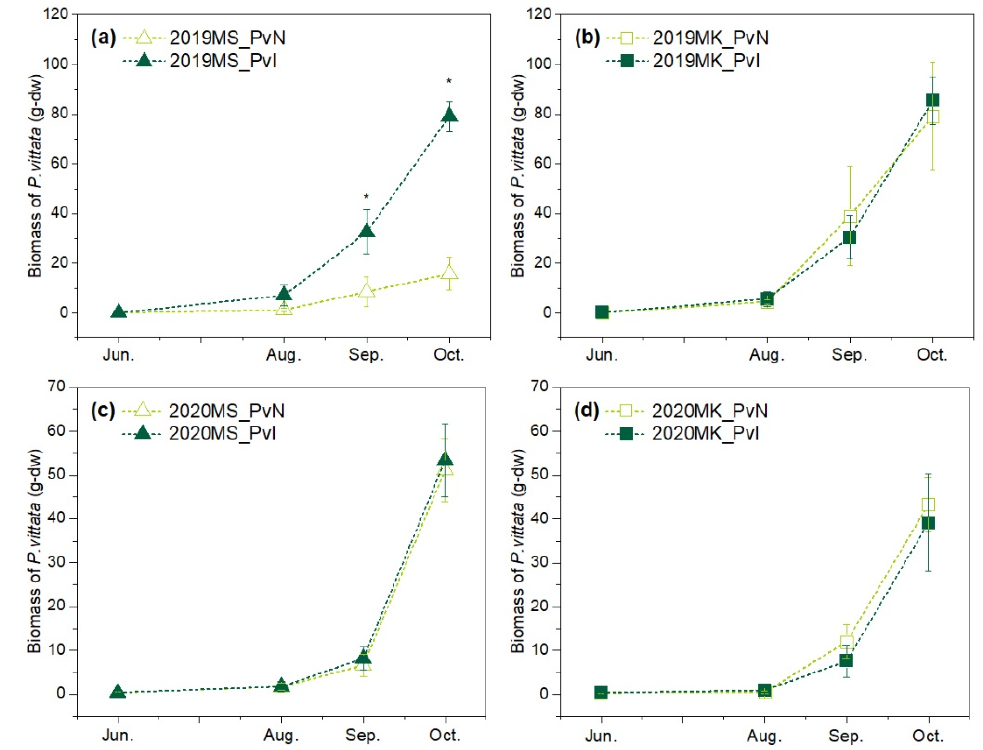
Figure 2. Biomass of P. vittata in ( a ) site MS in 2019 ( b ) site MK in 2019 ( c ) site MS in 2020, and ( d ) site MK in 2020. * indicate significant differences ( p < 0.05) according to ANOVA by Tukey HSD test. Table 2. The parameters regarding As removal per square